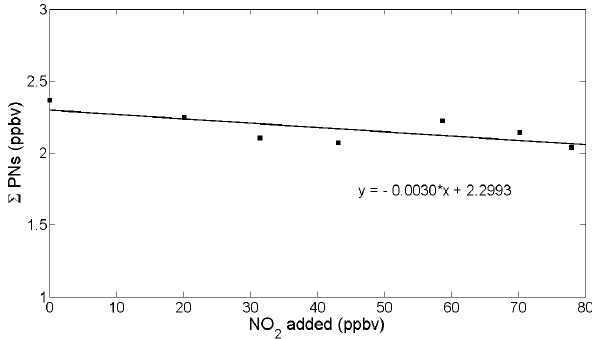
Figure 8. Measurements of ∑PNs when the TD-LIF sampled a mixture of PAN and different 2 Fig. 8. Measurements of P PNs when the TD-LIF sampled a mix- ture of PAN and different concentrations of NO 2 to check for pos- concentrations of NO 2 to check for possible interference due to the recombination of RO 2 and 3 sible interference due to the recombination of RO 2 and NO 2 NO 2 . 4